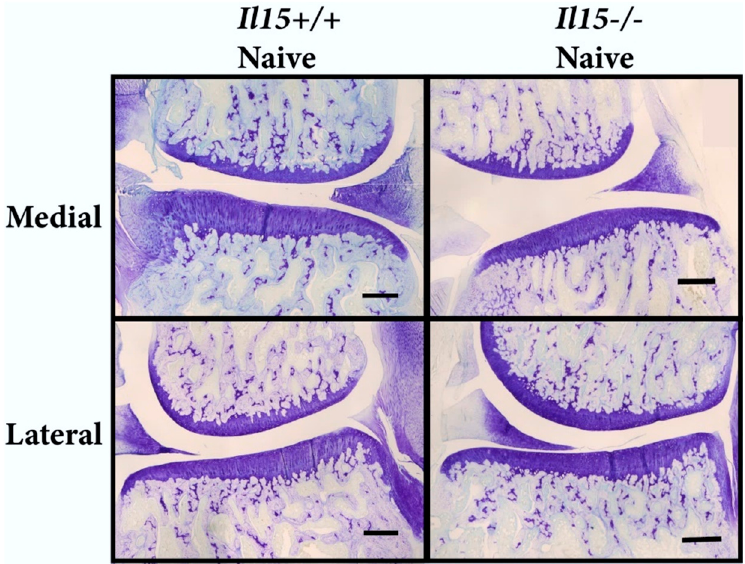
Figure 4. Representative histological images demonstrate healthy joint tissues in Naive rats. Representative images of toluidine blue-stained paraffin sections of rat knees, demonstrating that the Naive group had no significant differences between genotypes and appeared healthy. Semi-quantitative scoring demonstrates no significant damage to the articular cartilage, subchondral bone, and osteophyte formation. Images were taken at 4× magnification, scale bars represent 200 µm (N = 9 rats/Naive group).